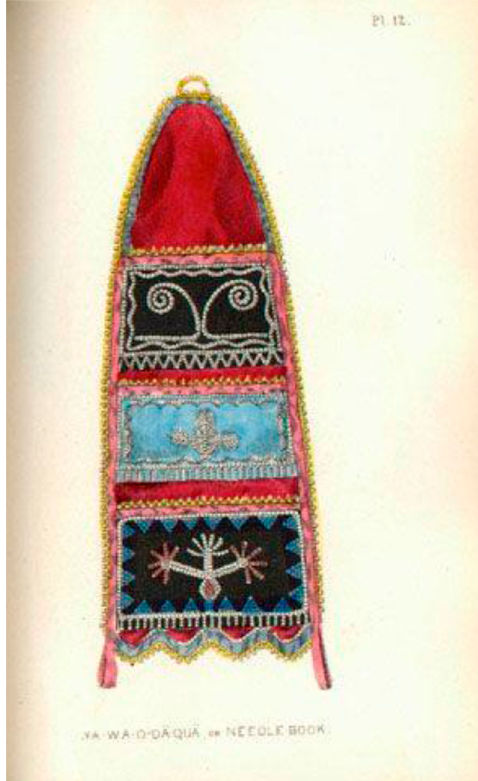
Figure 5. Haudenosaunee needle book from H.L. Morgan Report on the State Cabinet and Antiquarian Collection , 1850. Color lithograph, public domain.